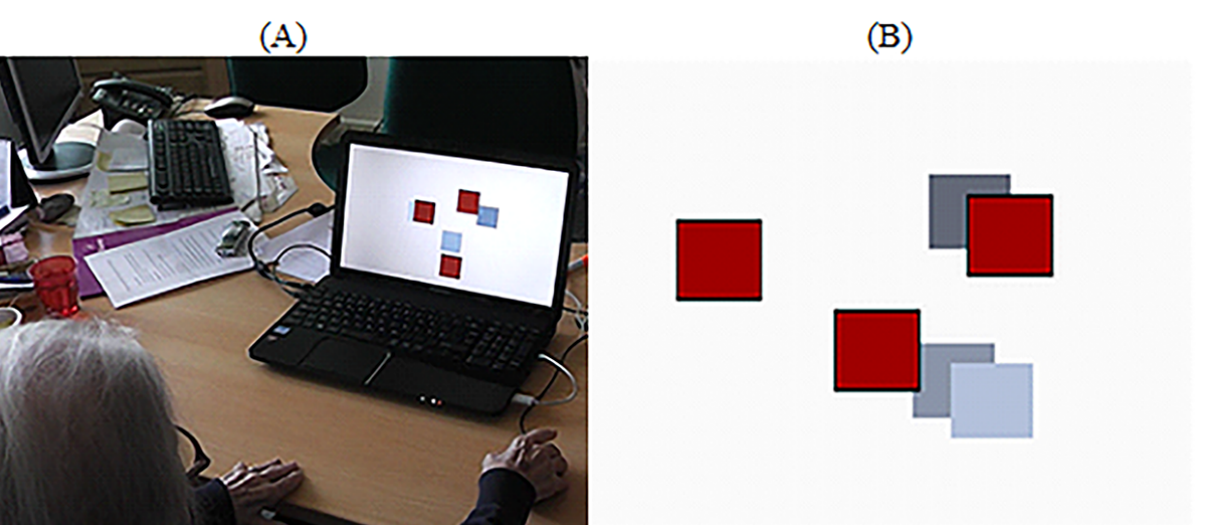
Figure 7. Connecting Squares. (A) Participants are trying to match red squares to gray squares. (B) Print screen of the game. A set of randomly distributed